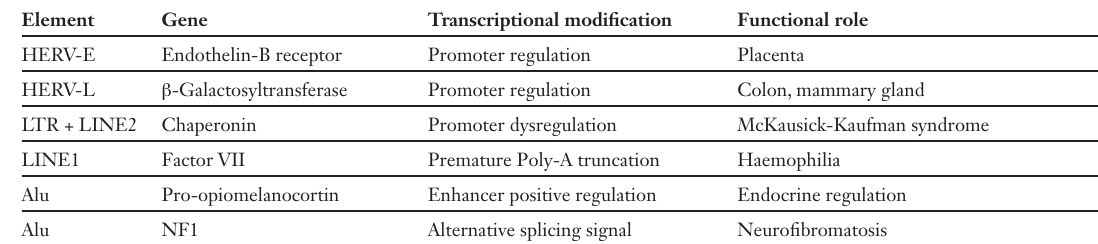
Positive and negative effects of retroele- ments as transcrip- tional modulators of host genes. Blue indicates pre- sumed favourable ef- fects of retroelement integration, red indi- cates detrimental in- tegration site. Adapted from ban- nert et al. [6].